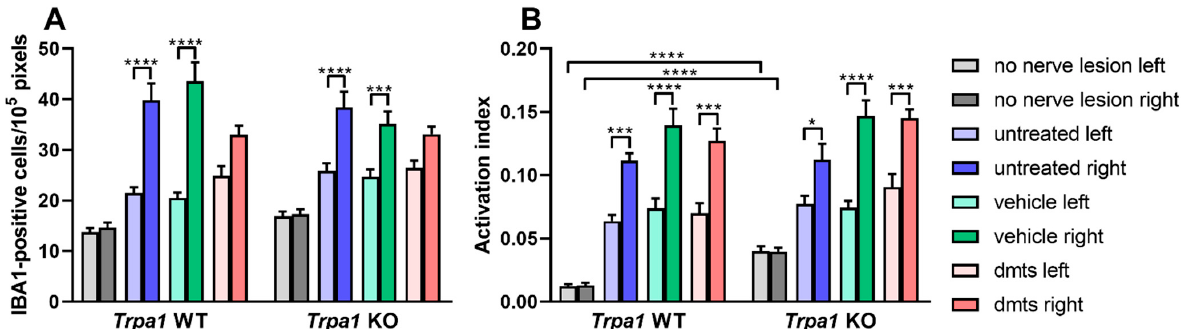
Figure 5. TRPA1-dependent relief of traumatic mononeuropathy by DMTS is not mediated by IBA1-positive cells of the spinal cord dorsal horn. Number ( A ) and activation index ( B ) of IBA1-positive microglia in the spinal cord dorsal horn of Trpa1 WT and KO mice with unilateral surgical lesion of the sciatic nerve. An activation index closer to 1 indicates larger cell activation. n = 3–5 animals, 2–13 slides per animal. We evaluated 13–34 photographs per group for cell density and 11–35 photographs to calculate activation indices. One-way ANOVA followed by Dunnett’s test. * p < 0.05, *** p < 0.001, **** p < 0.0001 vs. indicated groups.